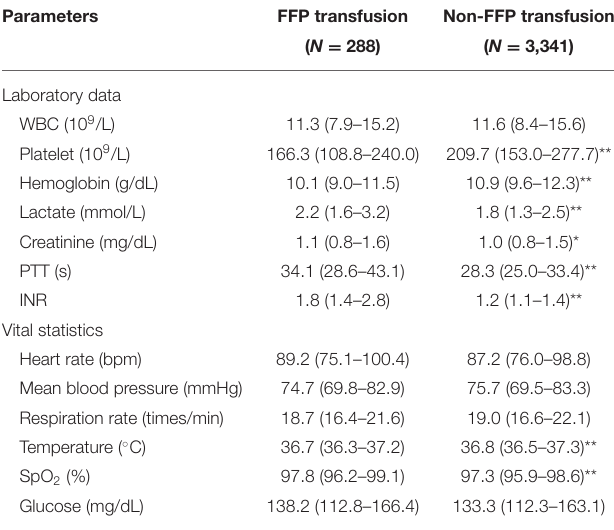
TABLE 2 | The baseline laboratory data and vital statistics.